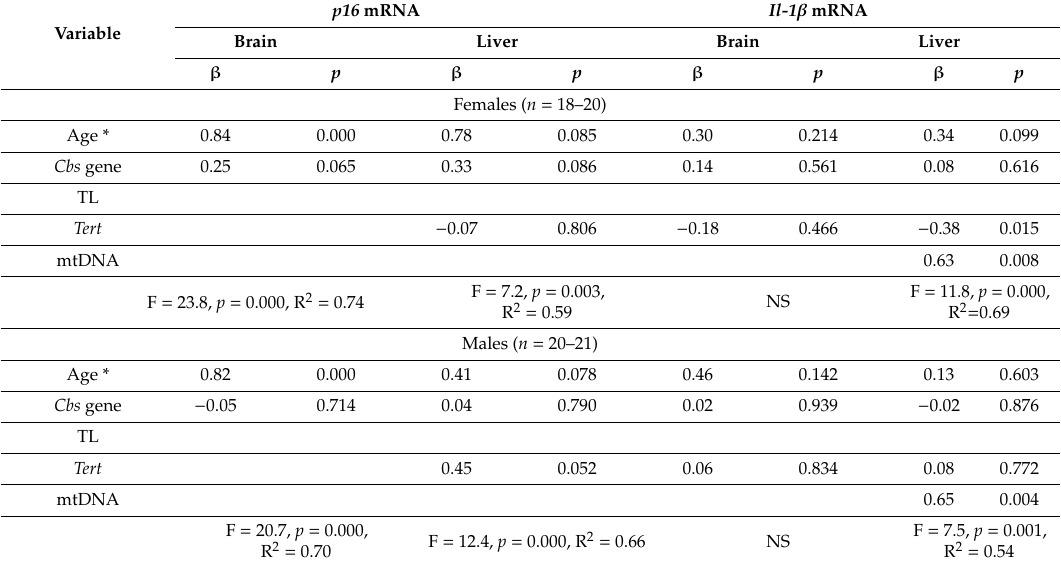
Table 5. Determinants of p16 and Il-1 β mRNAs in brains and livers of Cbs − / − and Cbs +/ − mice: multiple regression